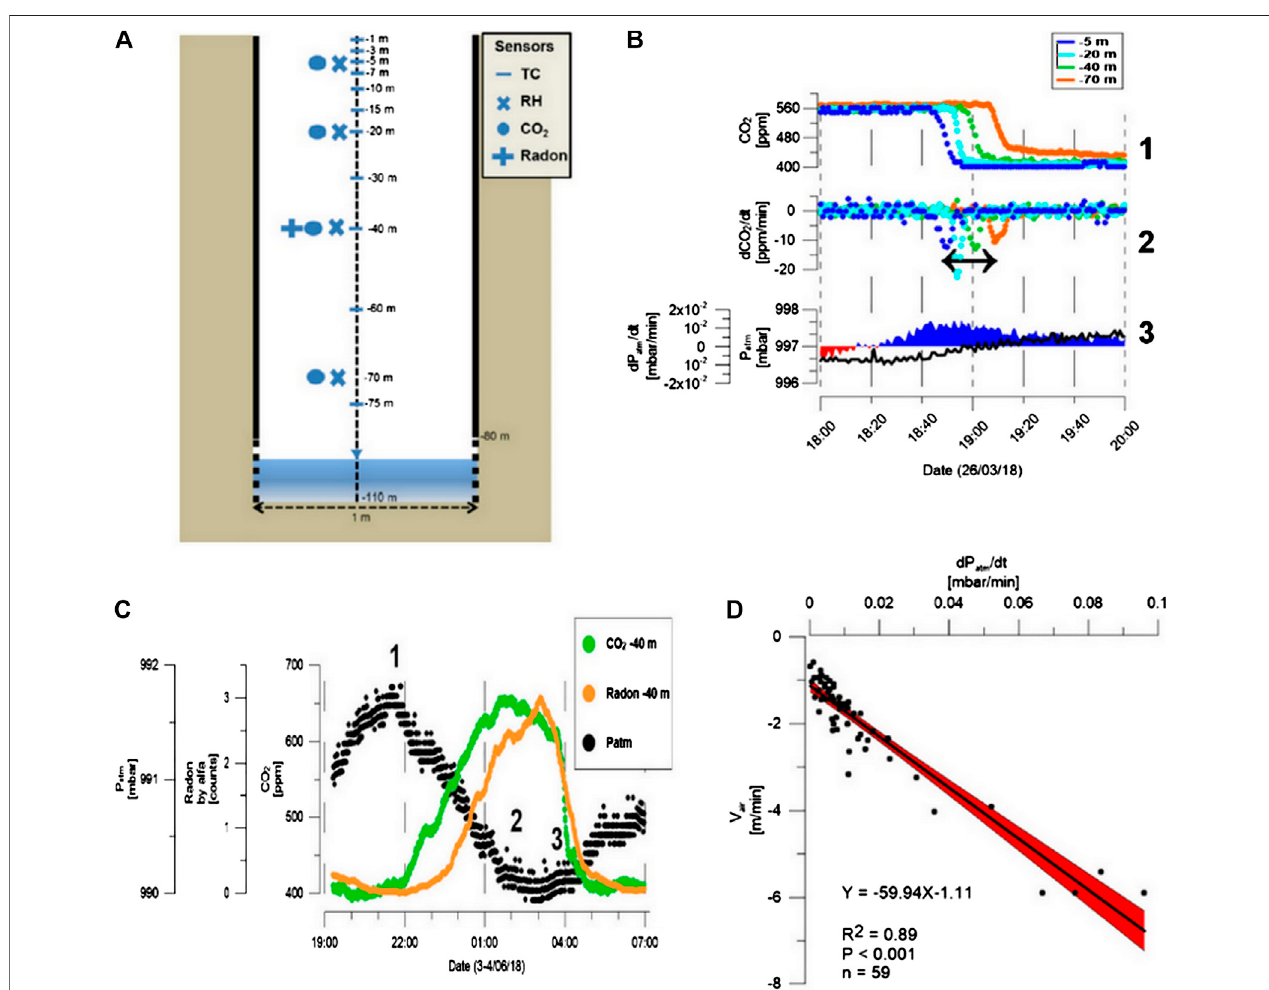
FIGURE 10 | Analysis of the relationship between air velocity (V air ) and atmospheric pressure changes (dP atm /dt). (A) Experimental setting. (B) Demonstrates the method using a single in fl ow event. (C) CO 2 and radon responses to changes in barometric pressure (P atm ). Labels 1, 2, and 3 refer to the time when P atm begins to decrease,becomesstable(i.e., betweenpoints 2and 3), and increases, respectively. (D) Plot displays V air asafunctionofdP atm /dtusing 59analyzed in fl oweventsover threemonths(March-May2018).Blackarrow in (A) denotesthetimeintervalbetweentheminimumdecrease valueofCO 2 (dCO 2 /dt)at − 5and − 70 m,fromwhich V air was quanti fi ed. Red area represents the 95% con fi dence range according to the calculated linear regression (black line) (Levintal et al., 2020).